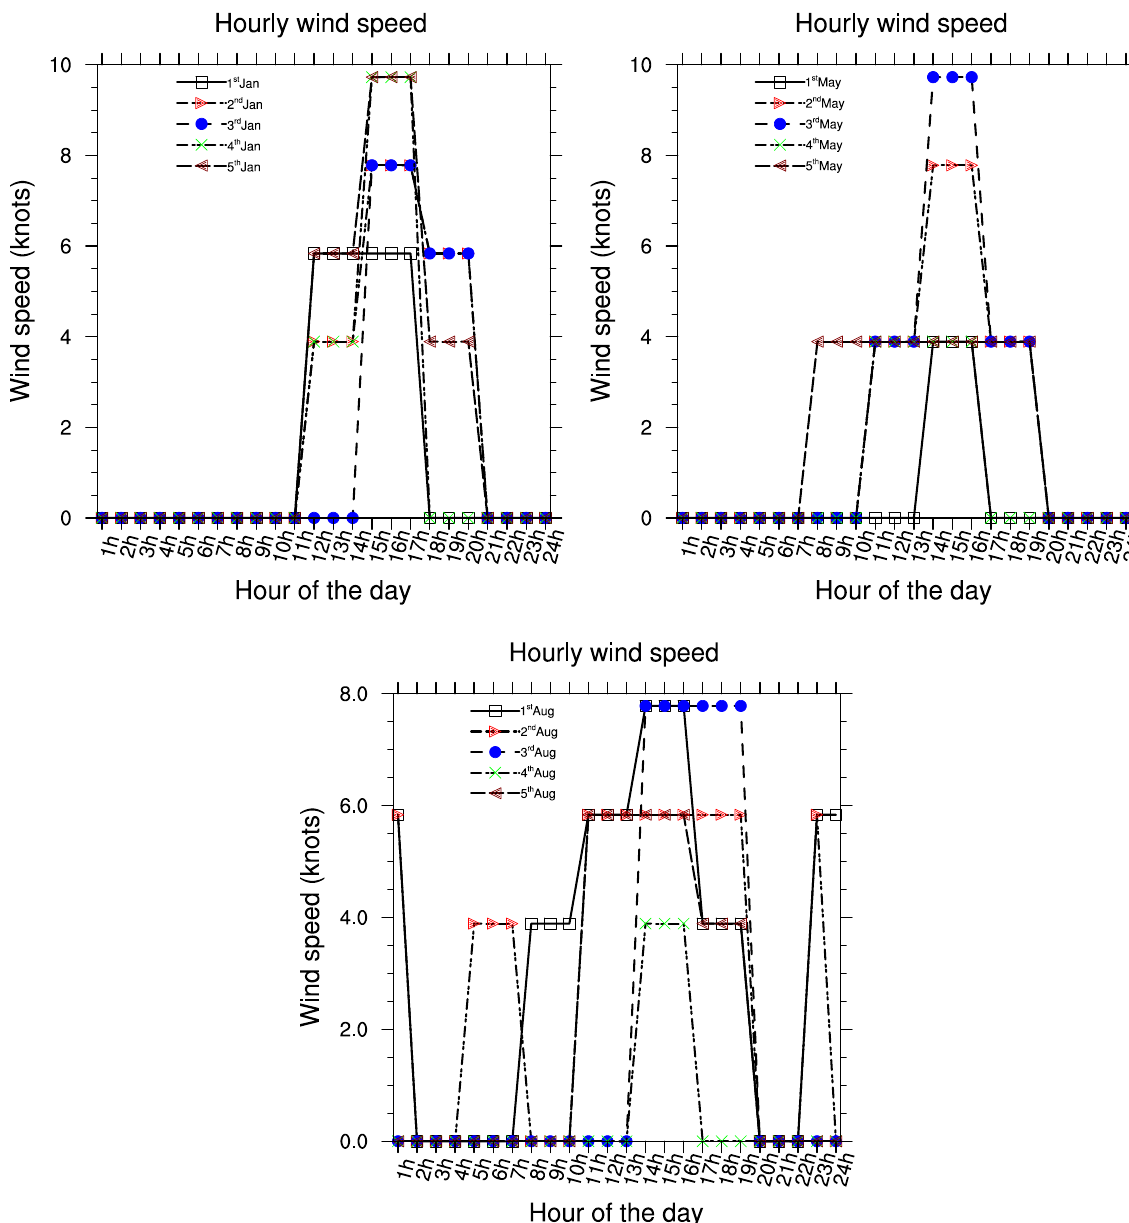
Figure 7. Daily wind speed for the first five days of the months of January, May and August for the year